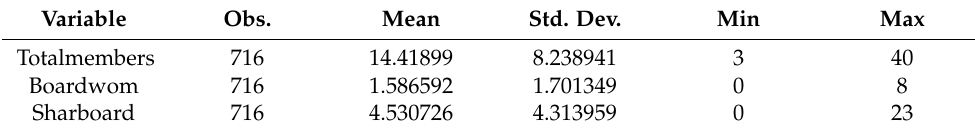
Table 5. Characteristics of the corporate governance.